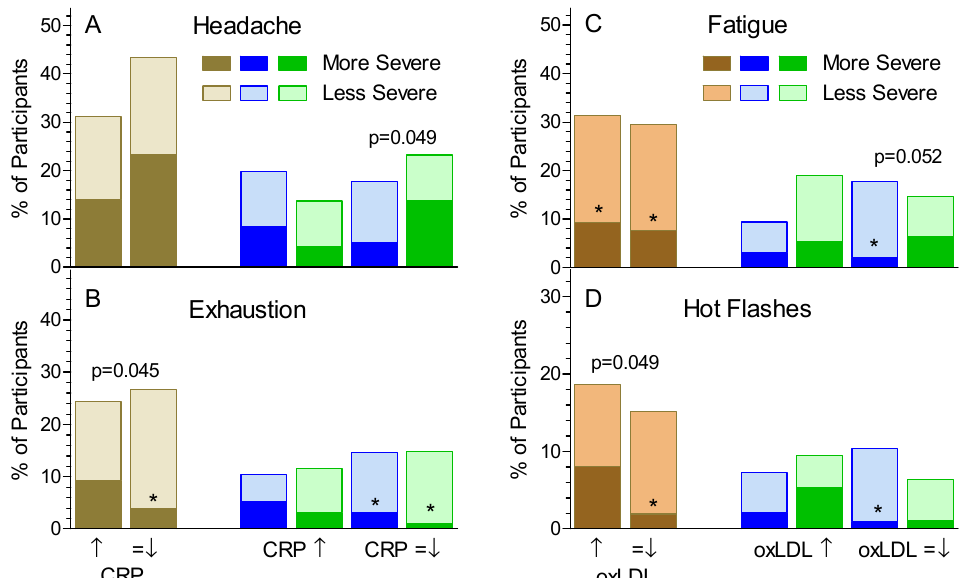
Figure 3. Effect of changes in serum CRP and oxLDL on symptom severity. Percent of participants whose symptoms became more severe (dark bars) or less severe (light bars) during treatment for those whose serum CRP (panels A and B ) or oxLDL (panels C and D ) increased ( ↑ ) or did not increase (= ↓ ) after 4 weeks treatment. The percent of participants with no change in severity is not shown. Brown/orange bars are for all participants, blue bars for Test and green bars for Control. p -values over 2 bars are the significance of the difference between the ratios of More:Less severe for the 2 bars (e.g., panel A, in participants whose CRP did not increase after 4 weeks treatment, Headache was significantly more severe in those on Control vs. Test p = 0.049). * Ratio of more:less severe differs significantly from 1:1 by chi-square test ( p < 0.05).